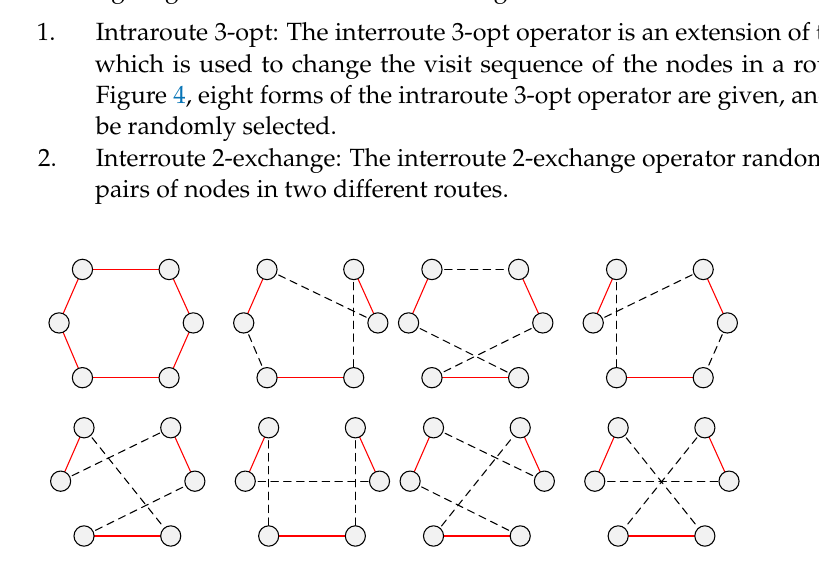
Figure 4. Eight forms of the intraroute 3-opt operator.